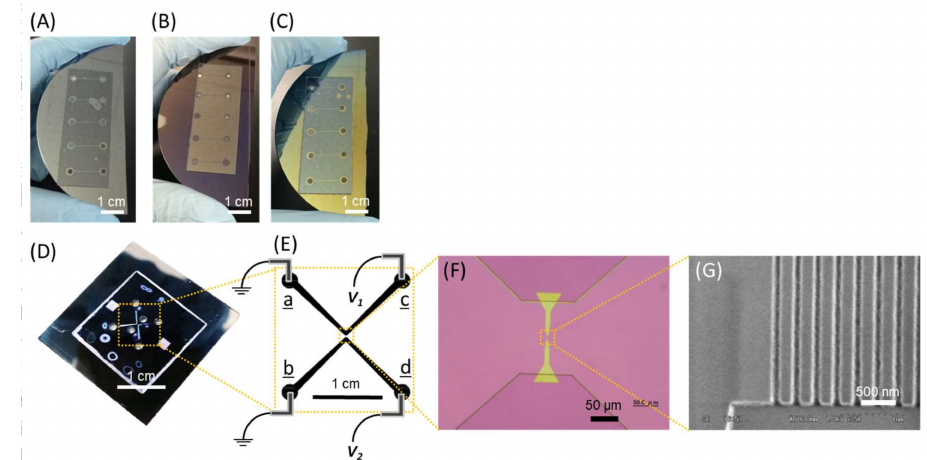
Figure 1. Microfluidic devices for dielectric breakdown experiments ( A – C ) and a nanofluidic